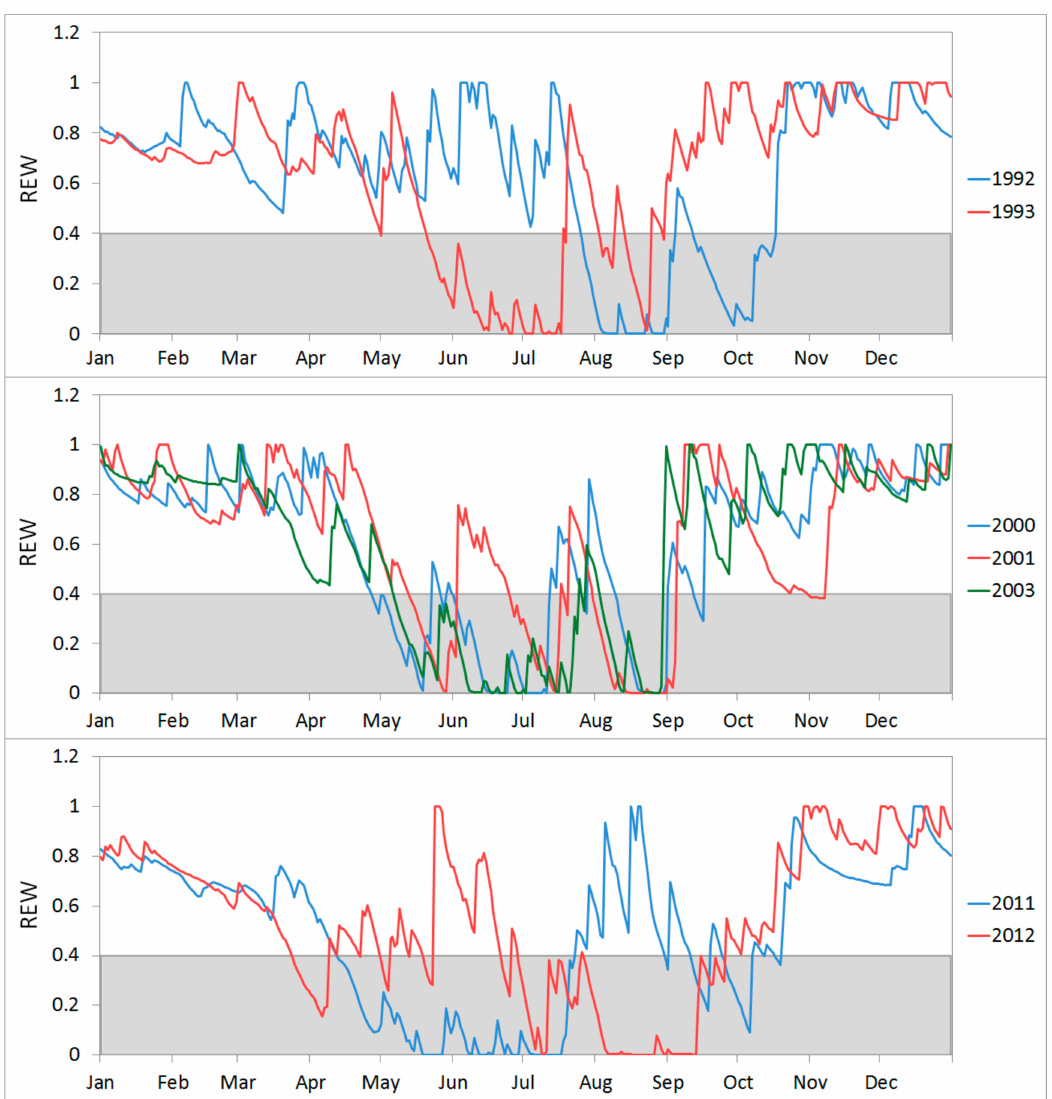
Figure 10. Daily relative extractable water (REW) of the analysed drought years, grey area denotes the REW values below